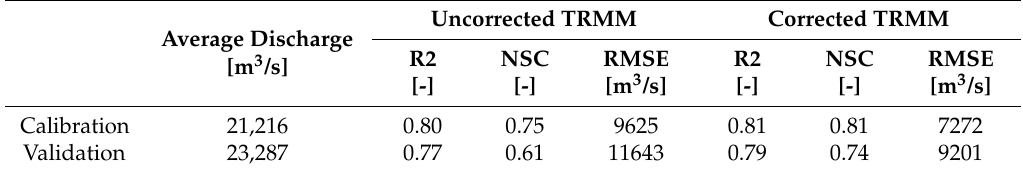
Figure 5. Comparison of the simulated (using uncorrected and corrected TRMM products) and observed hydrograph at Bahadurabad for the calibration (first row) and validation (second row) periods. Table 3. Analysis of accuracy of the hydrological model over the calibration and validation period with the uncorrected and corrected TRMM